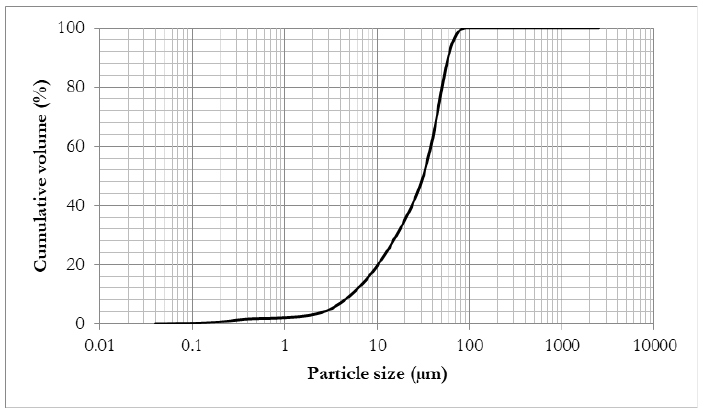
Figure 4. Granulometric curve of the silica fume.